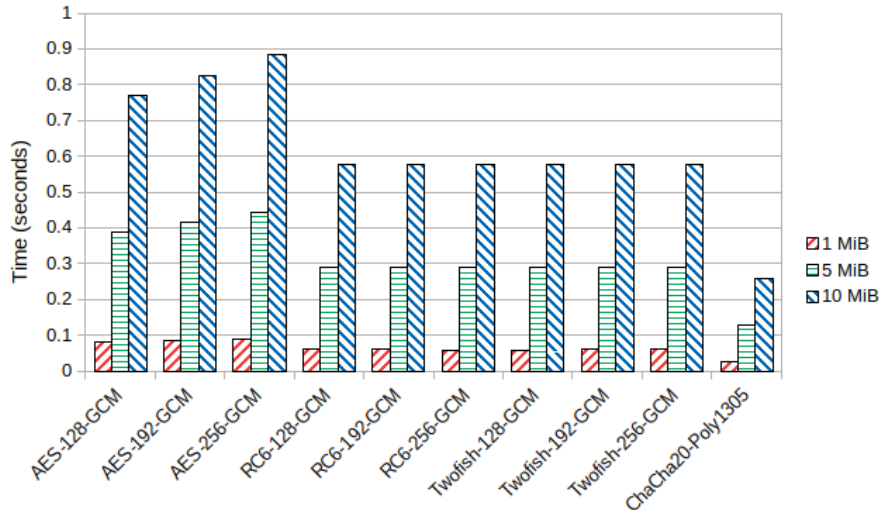
Figure 4. Average encryption time (seconds) in the ARMv7-a Samsung device.